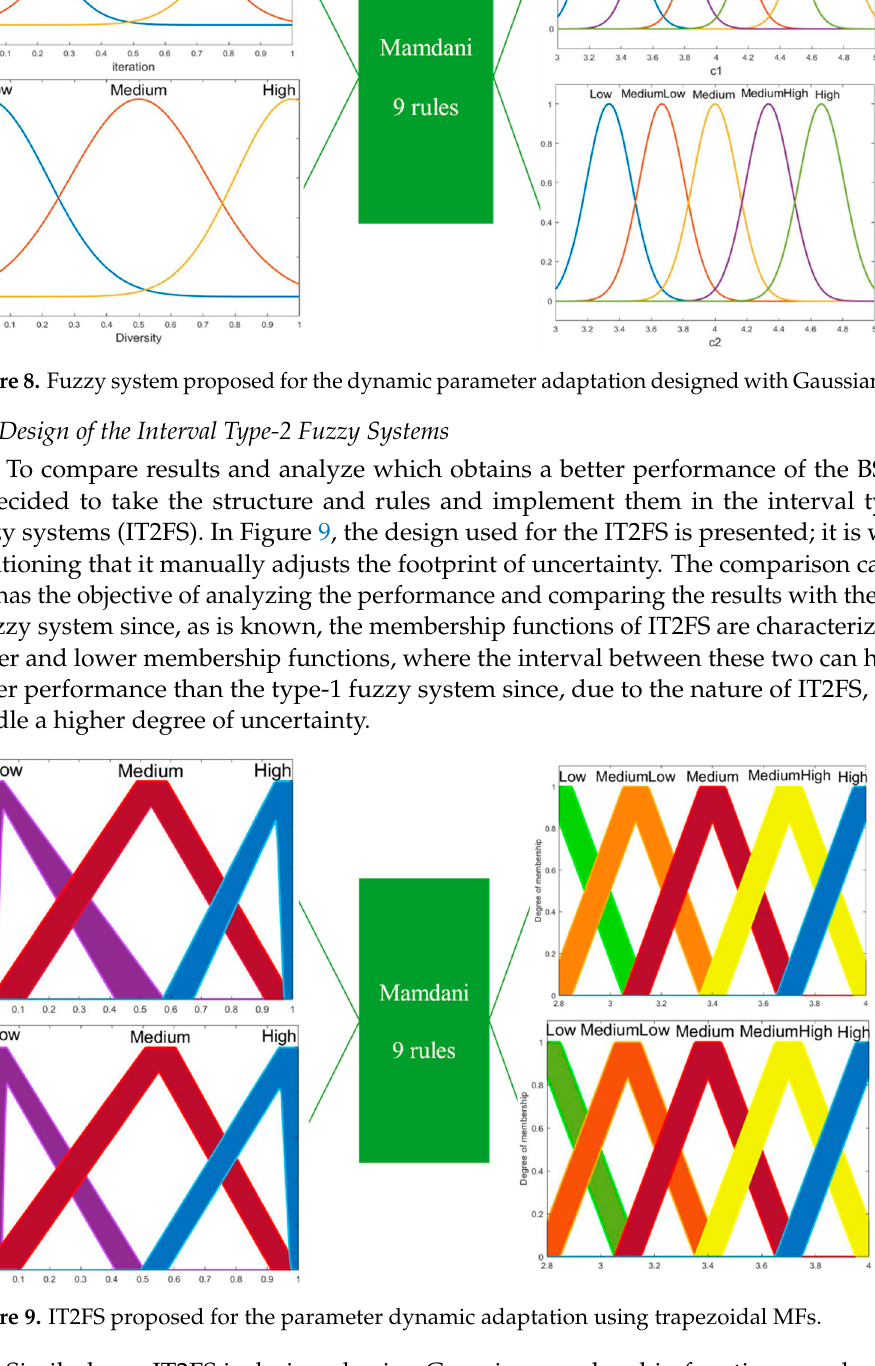
Figure 10. IT2FS proposed for the parameter dynamic adaptation using Gaussian MFs. 4.2. Study Cases 4.2.1. Design of Experiments Using CEC 2017 Functions In the first phase of the experimentation, the parameters presented in Table 2 are used as a basis, and these are taken from [52] to compare results. As mentioned above, it was decided to adjust C1 and C2 due to the different manual tests that were performed, changing the different parameters used in the algorithm, and observing which of these was a more significant change in the results.